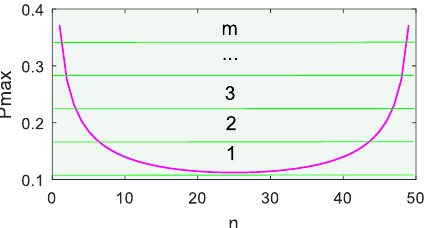
Figure 5. Maximum probability curve of binomial distribution with different p values.